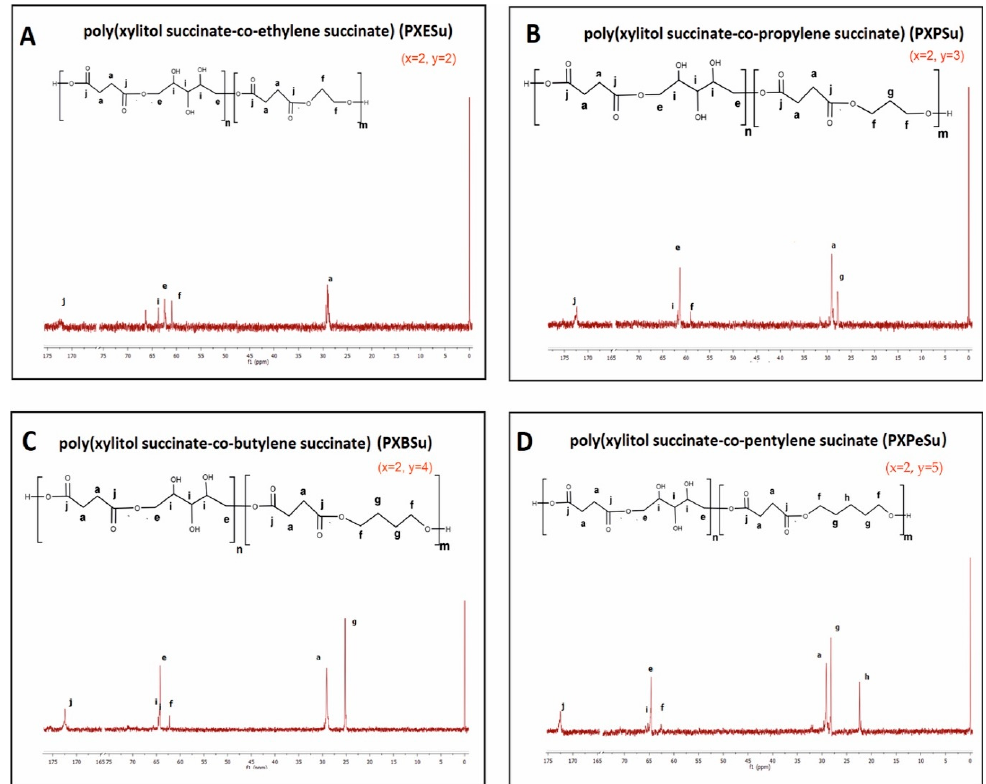
Figure 4. 13 C NMR of PXESu ( A ), PXPSu ( B ), PXBSu ( C ), and PXPeSu ( D ).